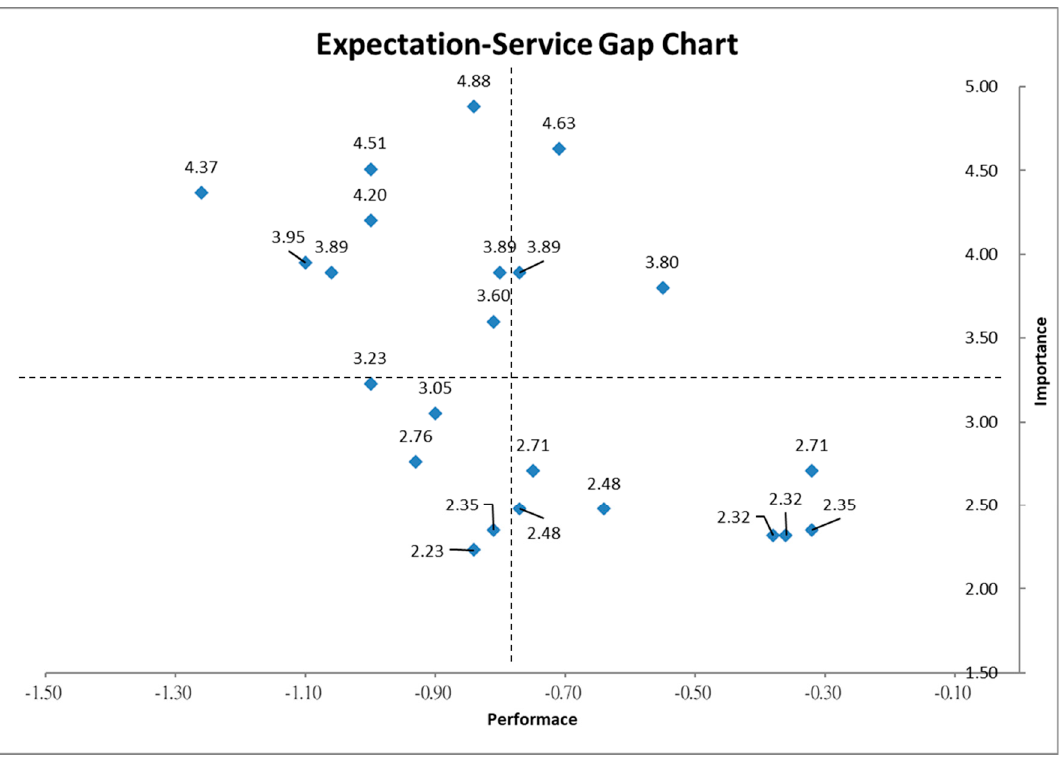
Figure 5. Importance-performance grid.